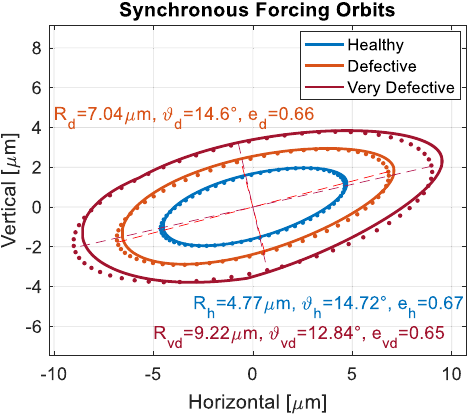
Fig. 10. Modelled orbits and their elliptical fi ts